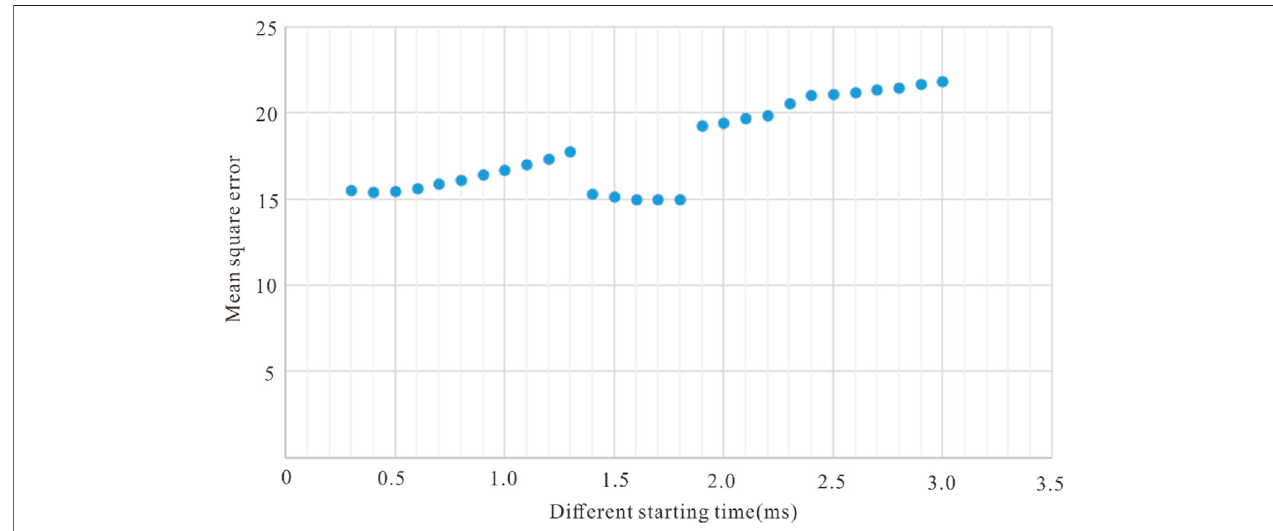
FIGURE 8 | Analysis table of the mean square error of different starting time values.